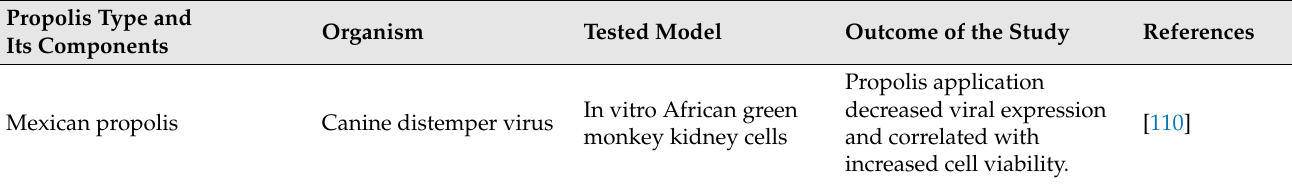
Table 3. Antiviral activities of propolis and its